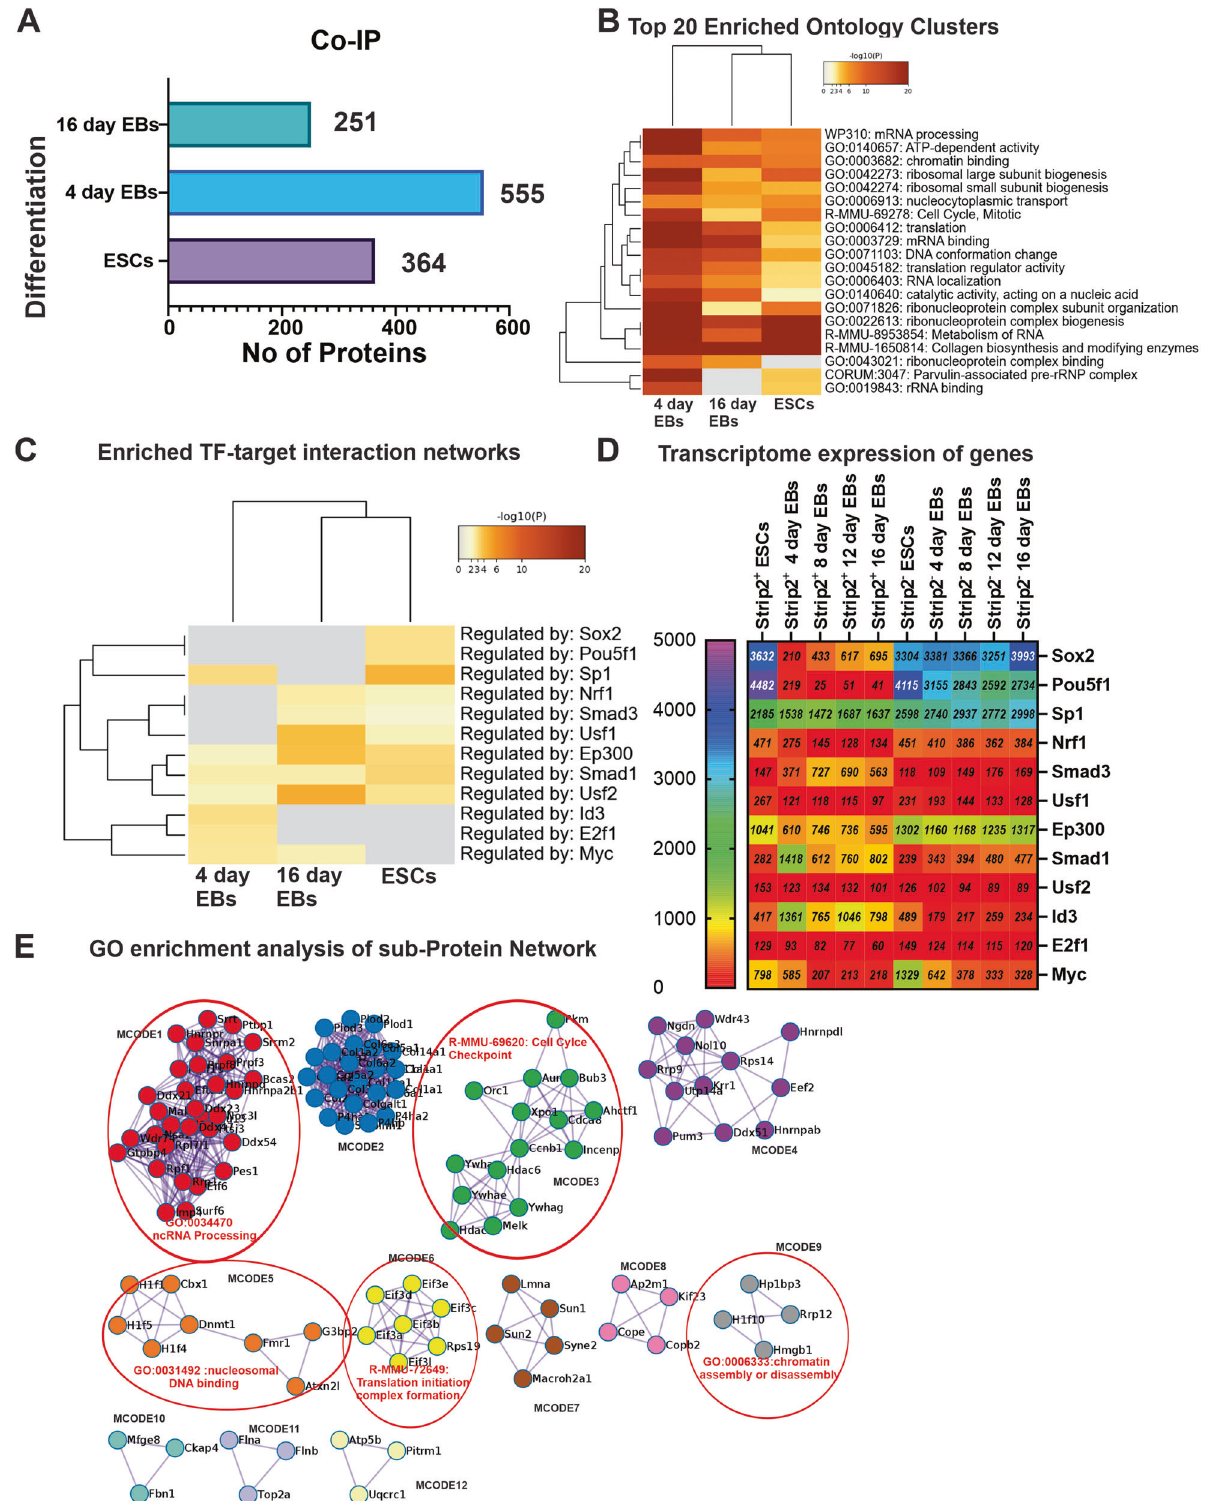
Fig. 4 Proteins interacting with Strip2 during murine ESC differentiation. A Bar graph representing number of proteins that were interacting with Strip2 at different points of differentiation (data derived using immunoprecipitation method). B Visualization of enriched ontology terms of proteins interacting with Strip2 in ESCs, 4-day and 16-day EBs. Heatmap showing the top 20 enrichment clusters, colored by p values. C Metascape enrichment analysis of all statistically enriched transcription factor-target interaction networks. D Gene expression pro fi le of enriched transcription factor-target interaction networks. E GO enrichment analysis was applied to each MCODE network to assign “ meanings ” to the network component, where the top three best p value terms were retained. MCODE components were identi fi ed from the merged network. Each MCODE network is assigned a unique